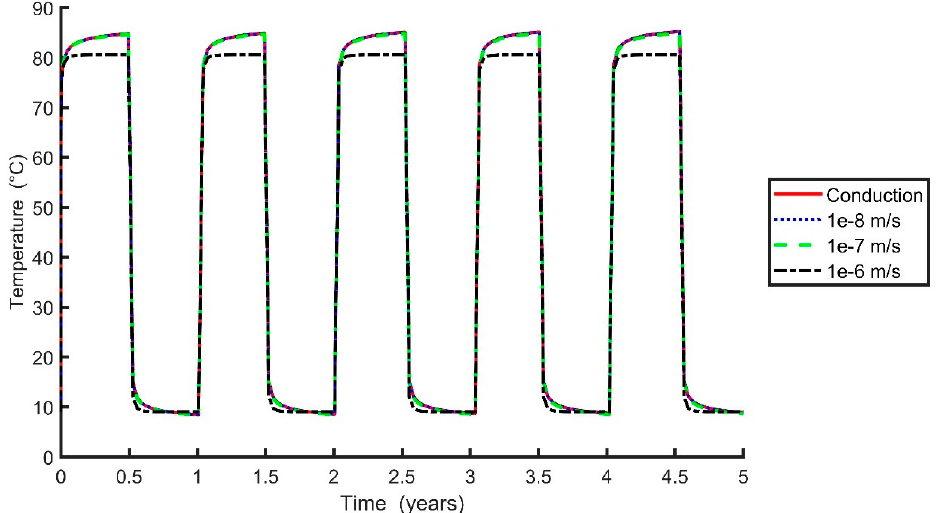
Figure 13. Simulated outlet fluid temperature over multiple charge-extraction cycles. Inlet is fixed at 95 °C during charge and 5 °C during extraction.